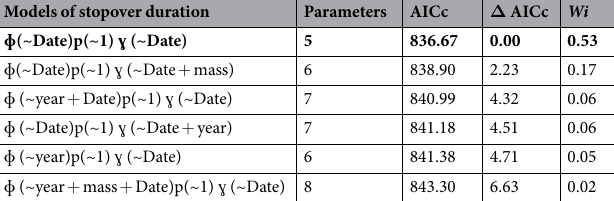
Table 1. 20 Cormack-Jolly-Seber models were evaluated to determine total stopover duration of untagged Grey-cheeked Thrush during the spring migrations of 2015 and 2016 in northern Colombia. Of these, the top model had a 0.53 weight and was used to obtain the probability estimates of ɸ (survival), ɣ (seniority) and p (recapture). See Table S2 for the complete list of